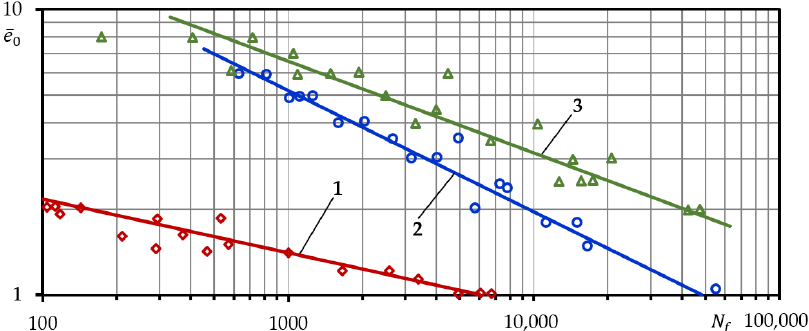
Figure 4. Low-cycle fatigue durability curves under strain-controlled loading: 1 — aluminum alloy D16T, 2 — alloyed steel 15Cr2MoVA, 3 — structural steel C45.